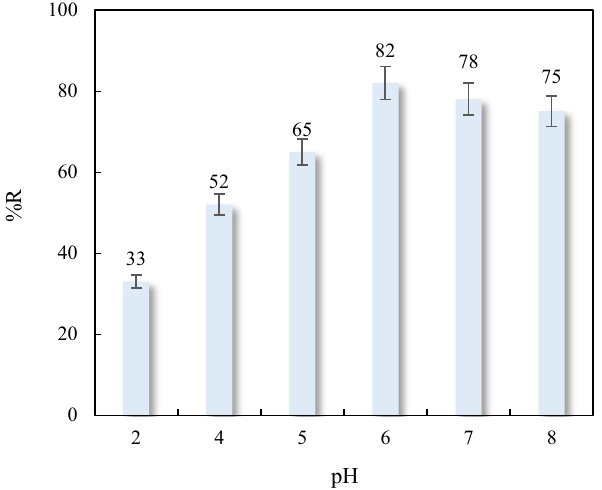
Figure 6. Influence of pH value on Cu (II) adsorption on marble waste sludges (25 °C, C 0 = 25 mg L −1 , 0.1 g of adsorbent).